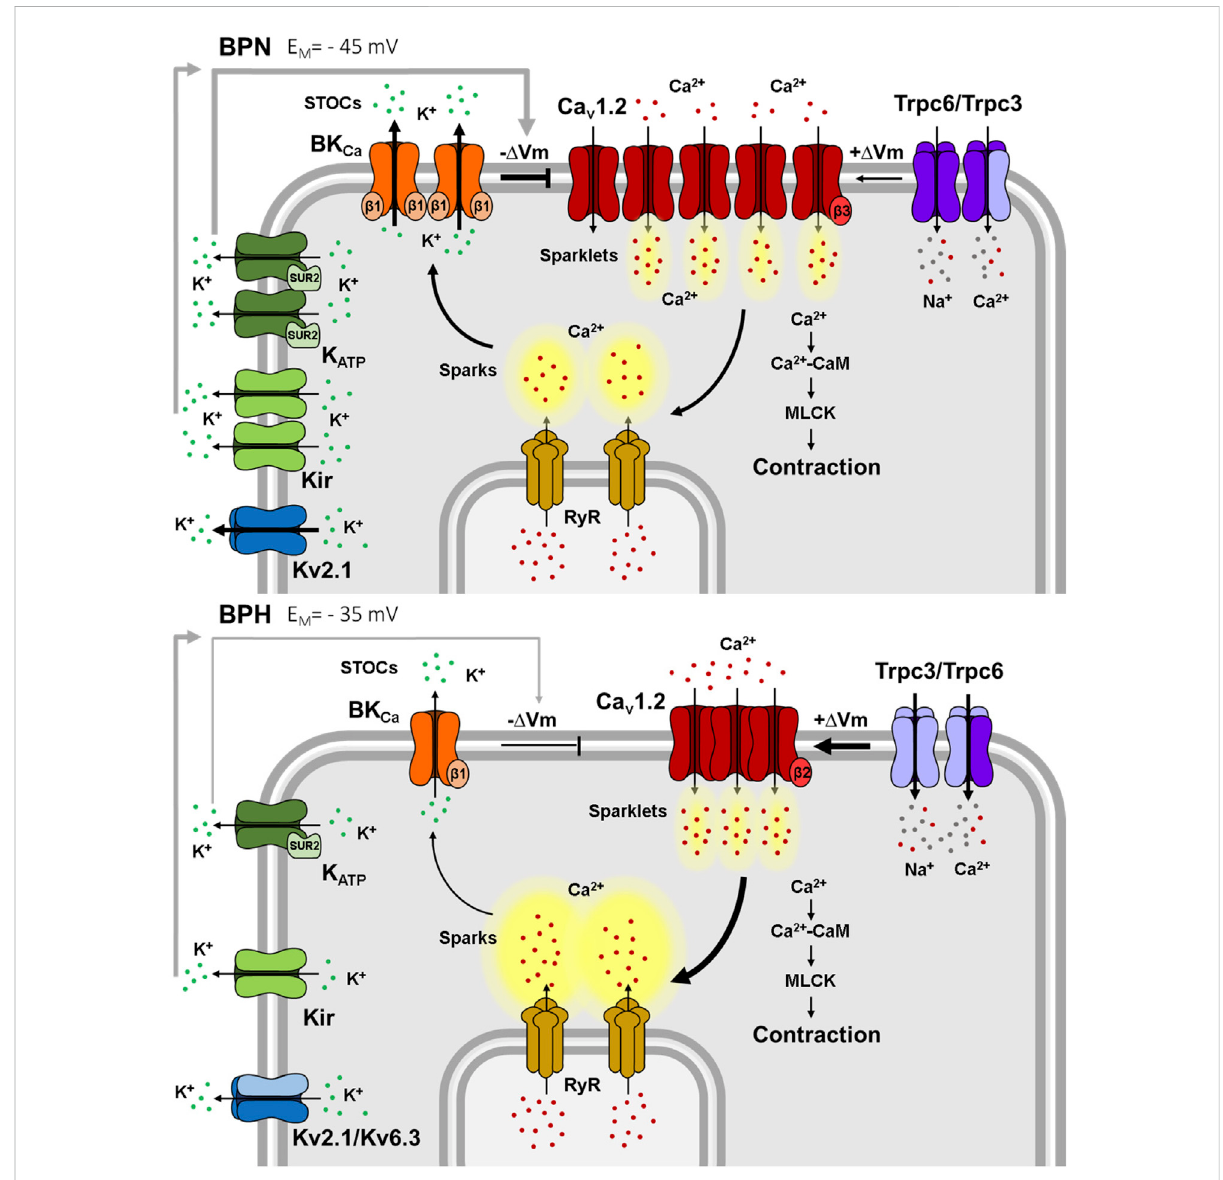
FIGURE 2 Ion channels differences between mesenteric BPN and BPH VSMCs. Smaller K + currents in BPH cells lead to a depolarized resting V M . Kv2.1currentsaresmallerbecauseofthe “ denovo ” expressionoftheKv6.3subunit.Kir,K ATP andBKchannelsfunctionalexpressionissmaller,andBK have a decreased sensitivity to Ca 2+ due to the decreased expression of the BK β 1 subunit. BPH VSMCs also have a higher expression of TRPC3 and a different composition of the TRPC3/TRPC6 heterotetramers. Larger TRPC currents contribute to the depolarized resting V M . Surprisingly, Cav1.2 expression and total Ca 2+ currents are smaller in BPH, but the different expression of β subunits generate clusters of channels that produce higherCa 2+ sparkletsandinducelargerRyRCa 2+ sparks.However,theselargersparksdonotinducelargerSTOCs,duetothereducedCa 2+ sensitivity of BK channels, jeopardizing the “ Ca 2+ break ” . Ca 2+ (red dots), K + (green dots) and Na 2+ (grey dots)